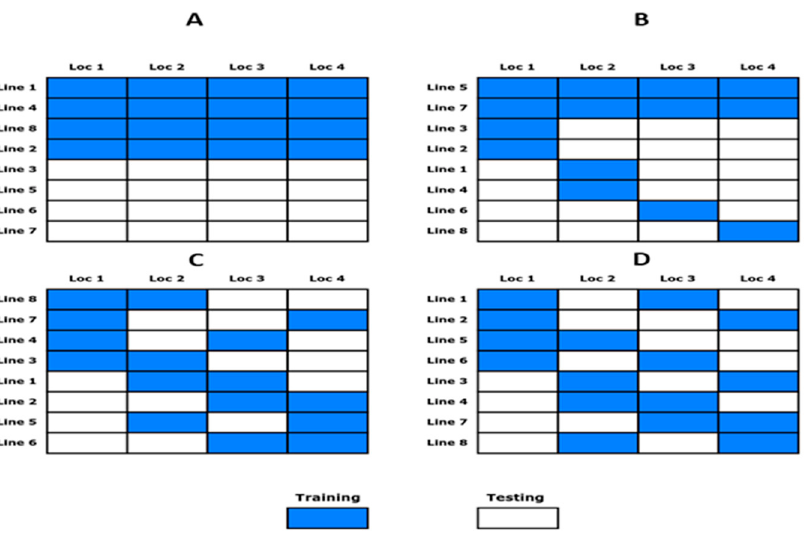
Figure 1. Allocation methods with eight lines and four locations for a partition, with 50% of lines as training and 50% of lines as testing. ( A ) M1 denotes the allocation of some lines in all locations, ( B ) M2 denotes the allocation of a subset of lines with some shared lines in locations, ( C ) M3 denotes the random allocation of some lines to locations under incomplete locations, and ( D ) M4 denotes the allocation of a fraction of lines to locations using the IBD